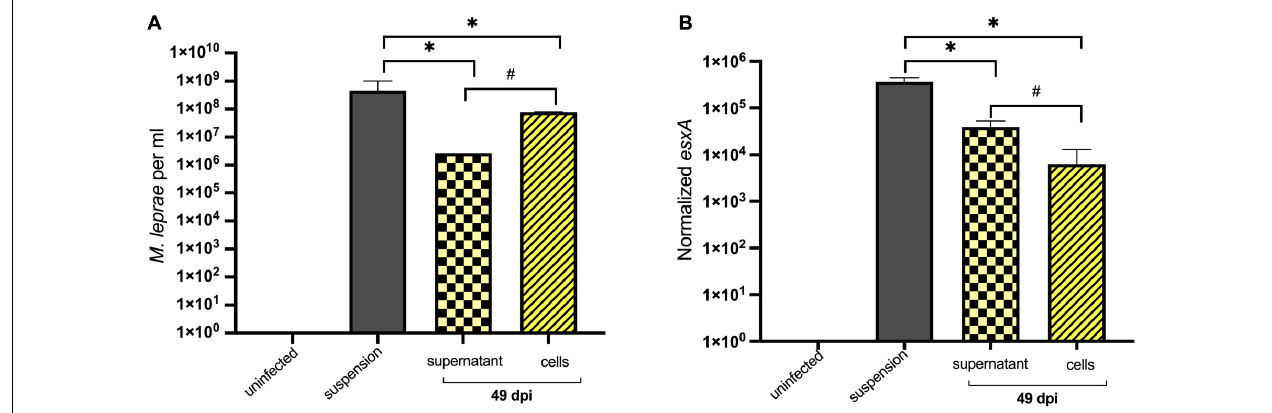
FIGURE 4 | Enumeration and viability of intracellular and extracellular M. leprae Thai-53 strain in tick cell culture. ISE6 cells were infected with M. leprae at approximately a multiplicity of infection (MOI) of 15. Infected cells and supernatant were collected separately at 49 dpi. (A) Enumeration was accessed by qPCR of RLEP. (B) Mycobacterium leprae viability was determined by detecting esxA . Statistically significant differences (Mann-Whitney test; p < 0.05) were indicated by ∗ or # when comparing with initial suspension or between groups, respectively.